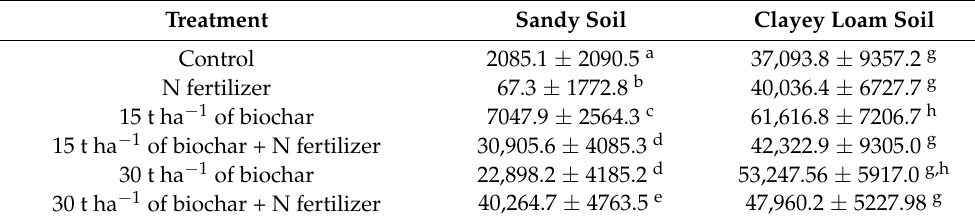
Table 1. Mean values of cumulative CO 2 fluxes (mean ± standard errors) from the sandy soil and the clayey loam soil with different treatments at the end of the incubation